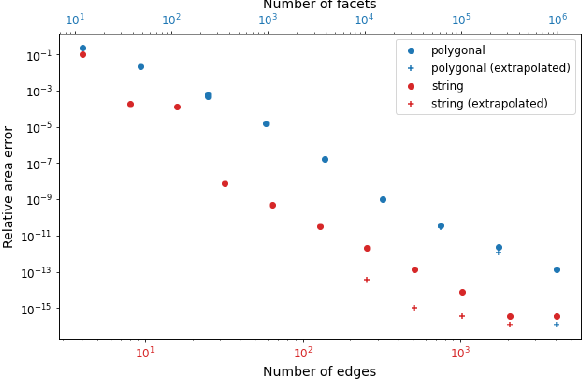
Figure 16. Convergence of minimal surface area with increasing refinement for both the string and polygonal models. In both cases, the cylinder has radius R = 1 and cutoff (cid:15) = 0 . 01 . The vertical axis shows the relative difference between the numerical and analytical areas. The cross points show values produced using the built in Evolver extrapolation